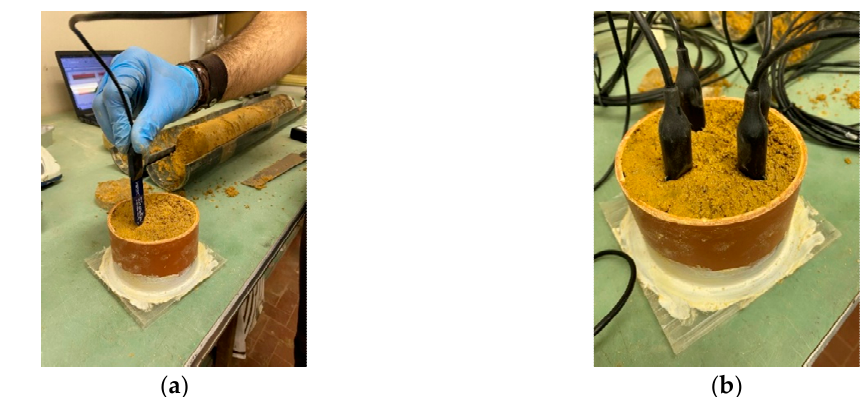
Figure 8. ( a ) Insertion of the first moisture sensor into the wet sample; ( b ) Final arrangement of the four sensors.